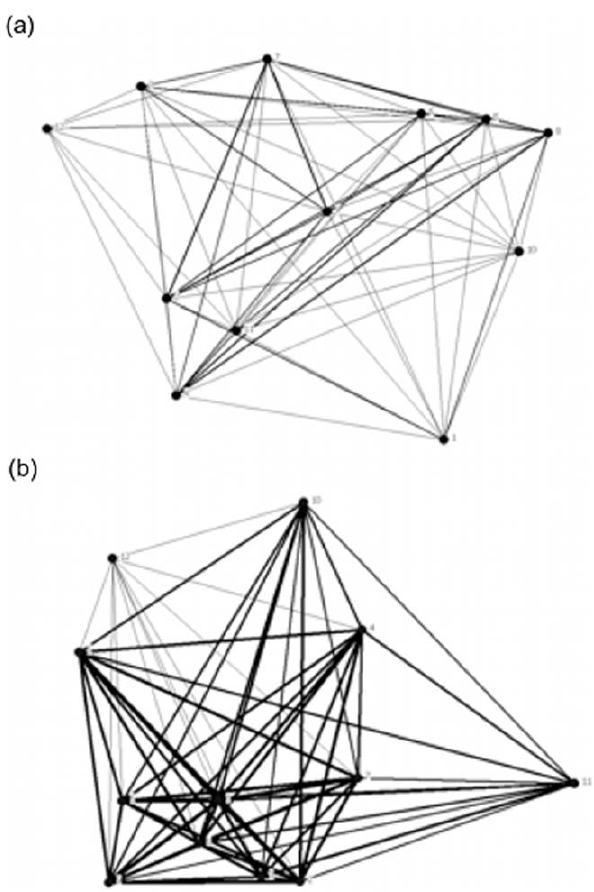
Figure 2. Example of social networks for female guppies collected from habitats differing in predation risk. Fish were from a low predation (a) and high predation (b) population of the Tacarigua River, Trinidad. Associations are represented by lines (edges) between individuals, which are weighted so that stronger associations are shown with darker lines. Drawn in Netdraw [91]. doi:10.1371/journal.pone.0024280.g002 for high and low risk populations (Fig. 3a):